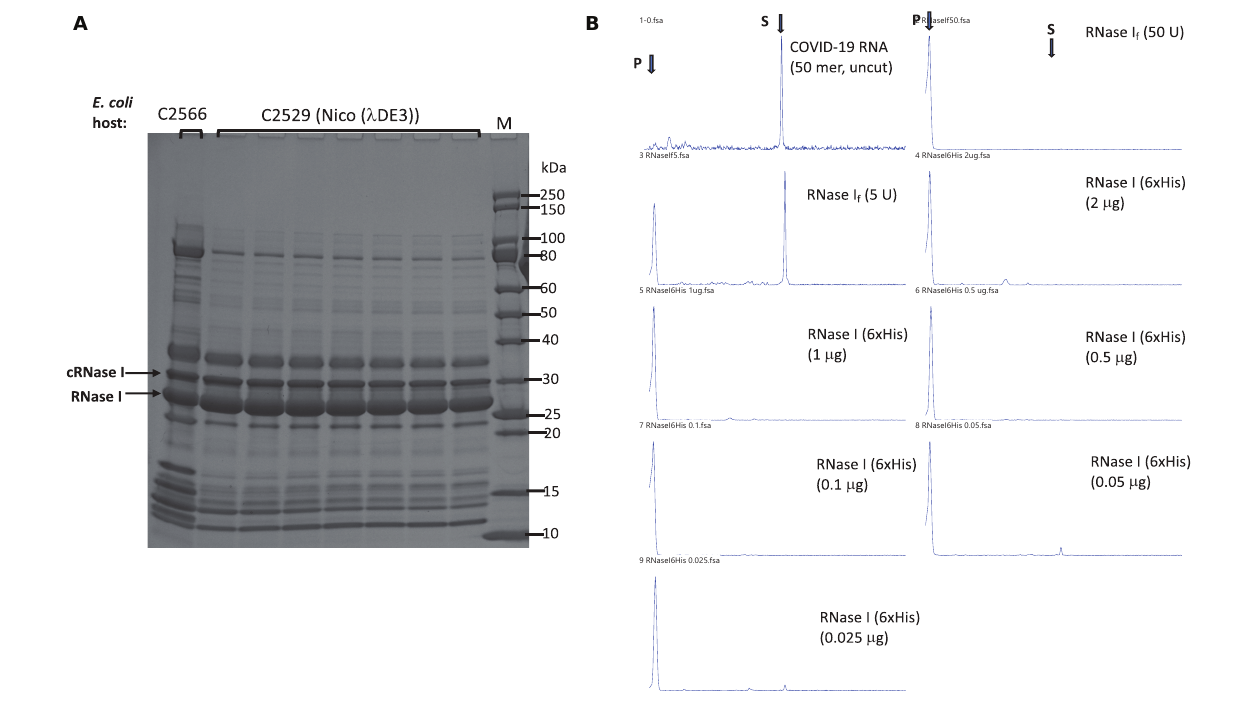
Frontiers in Microbiology |